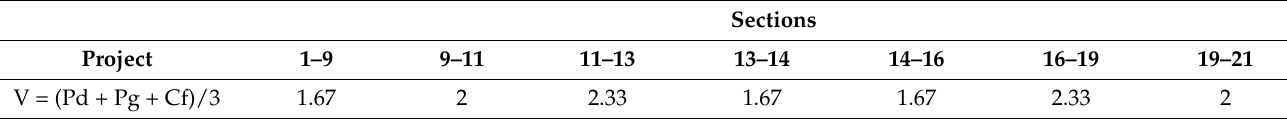
Table 1. Calculation of the vulnerability